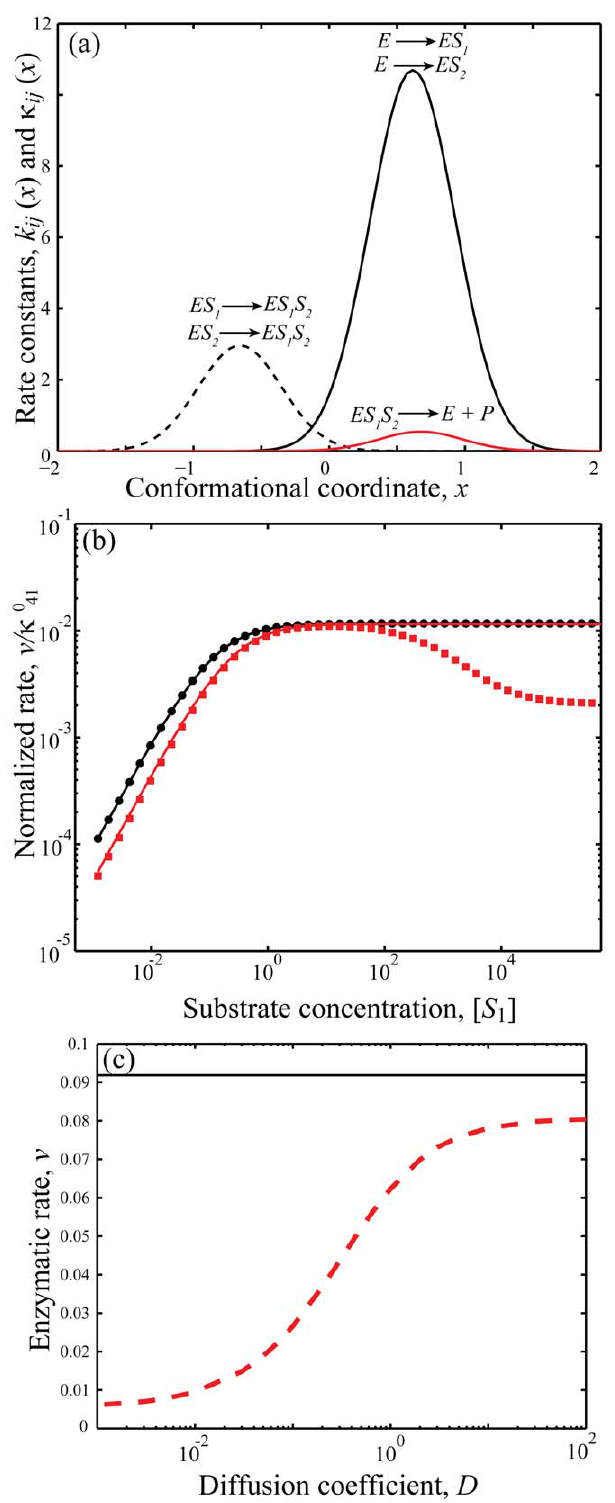
Figure 2. Numerical results for the random order bisubstrate reaction. (a) Rate constants k ij ( x ) and k ij ( x ) as function of the conformational coordinate x , with parameters given in Tables 1 and 2 h i. n o x ð Þ k B T . calculated from Eq. (34) and k ij x ð Þ ~ k 0 exp U i x ð Þ { U { ij ij as a function of concentration [ S 1 ] at a fixed (b) Normalized rate v (cid:12) k 0 41 ~ 10 , concentration of [ S 2 ]=10. When catalytic reaction is fast with k 0 41 slow diffusion in ES conformation leads to non-monotonic